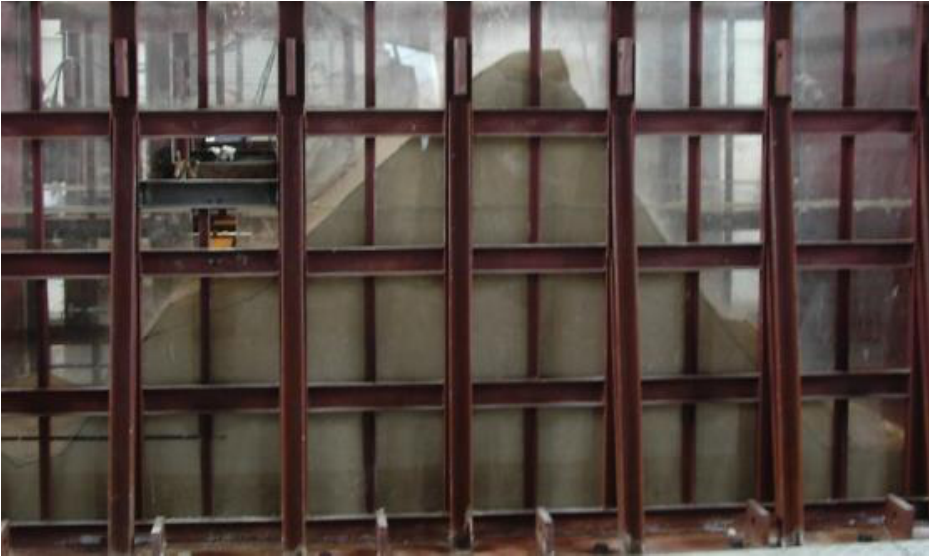
Figure 6. Shaking table test model of two-sided rock